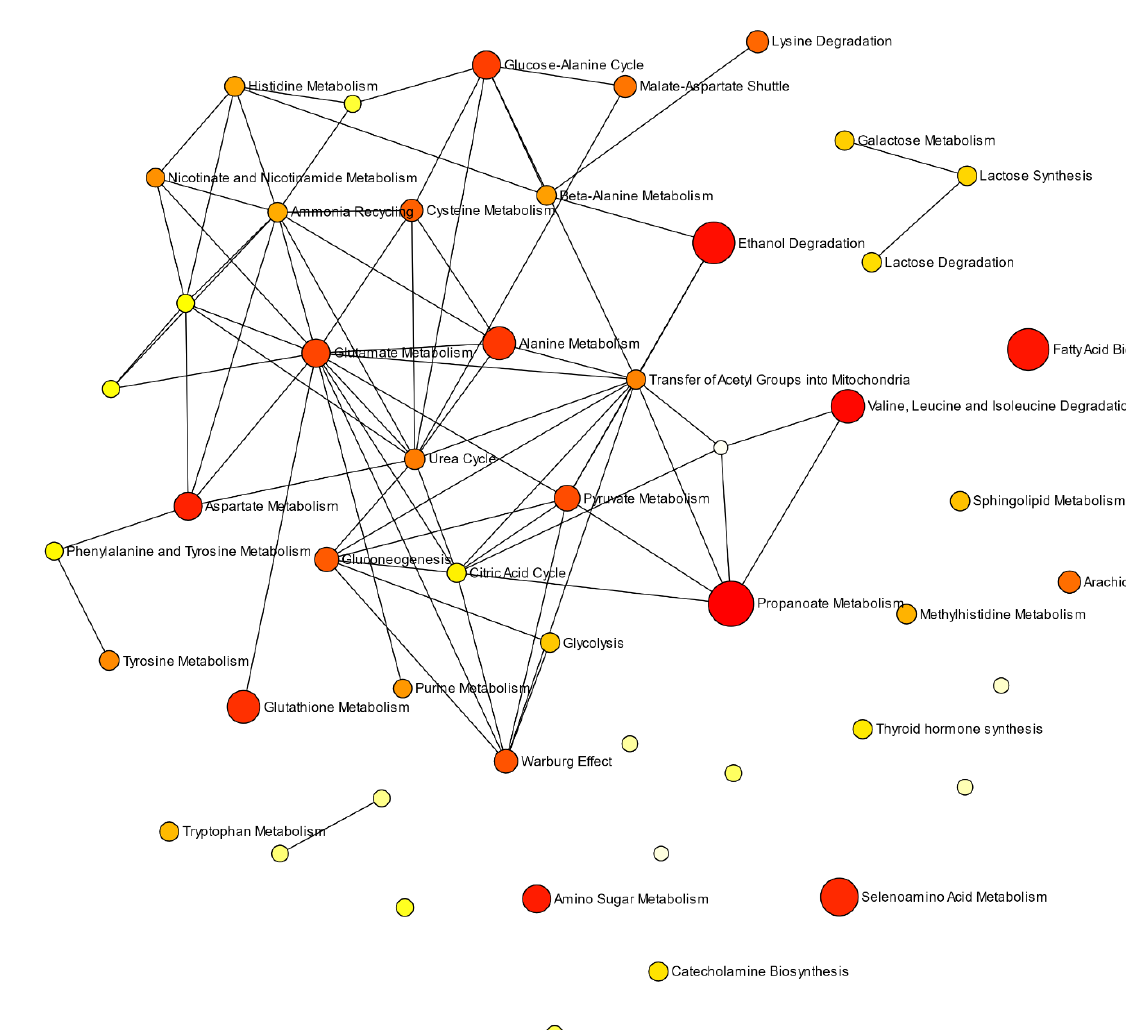
Figure 5. QMSEA metabolic pathway network analysis of GM1T2-mediated disturbances to plasma biomolecule patterns with MetaboAnalyst v4.0 . This analysis shows dysregulated metabolic pathways found, and interactions/connectivities between them. The statistical significance of imbalanced pathway features decreases in the color code order red > orange > yellow, and their overall GM1T2 disease impact is reflected by their radii, with the most affected ones being denoted by large values, the least affected by small ones.